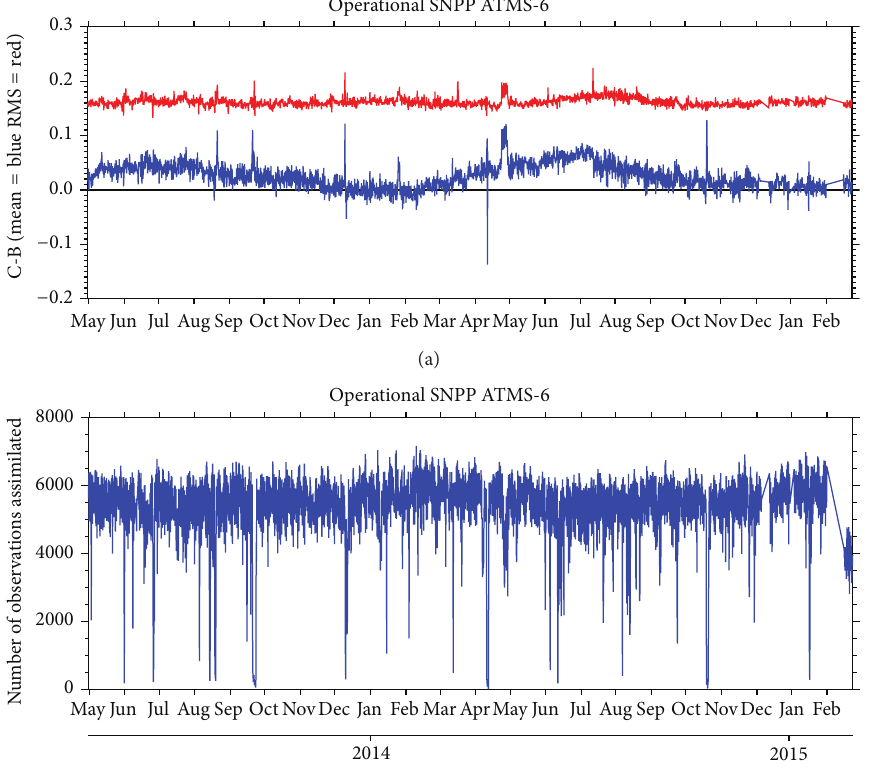
Figure 16: Time series for ATMS channel 6. (a) The mean (blue) and RMS (red) of the corrected innovations and (b) the assimilated observation count over a two-year period, May 2013–February